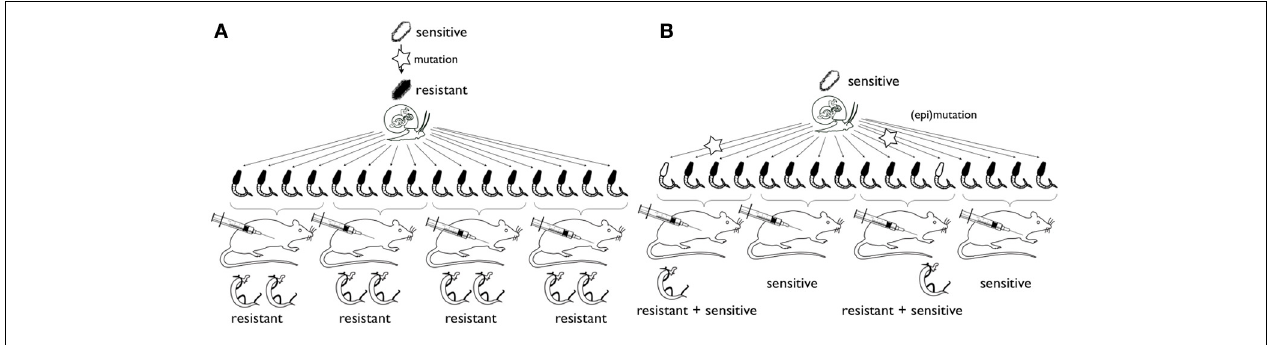
FIGURE 2 | Schematic representation of the experimental strategy for study of the origin of hycanthone resistance. Hypothesis (A) rare mutations (star) in miracidia (top) confer resistance to hycanthone. All offspring will be resistant (or sensitive, not shown). Hypothesis (B) epimutations or mutations occur during clonal amplification of cercaria in the